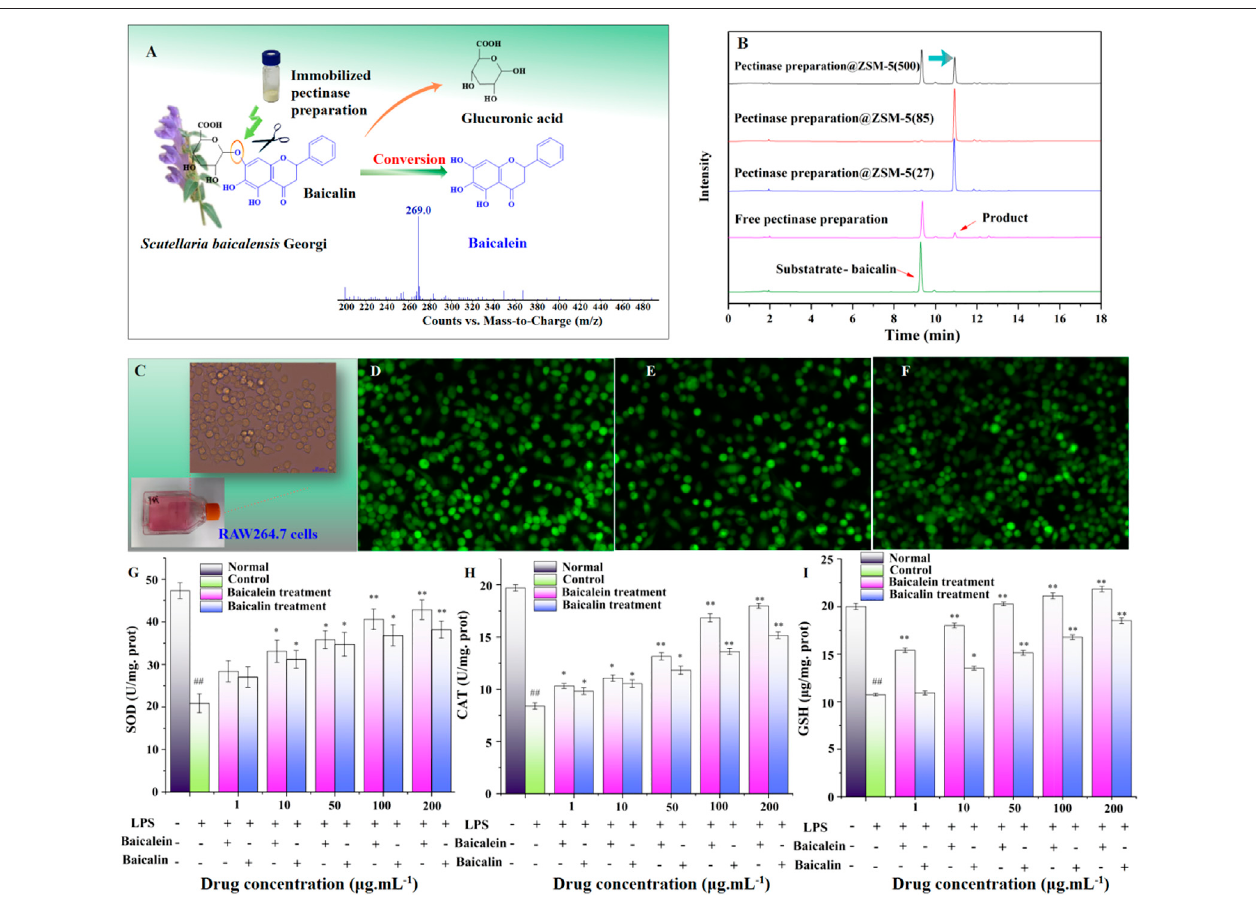
FIGURE 6 | Practical engineering application of pectinase preparation@ZSM-5: enzymatic hydrolysis of baicalin into baicalein. (A) Schematic illustration of the hydrolysis of baicalin to form baicalein using pectinase preparation@ZSM-5. (B) HPLC spectra of baicalin and as-prepared baicalein. (C) Photograph of RAW264.7 murinemacrophagecells. (D – F) Fluorescenceprobeconfocalmicroscopyimagesof (D) LPS-injuredRAW264.7cells, (E) baicalin-treatedLPS-injuredRAW264.7cells, and (F) baicalein-treatedLPS-injured RAW 264.7cells. (G – I) Effectofbaicalin and baicalein on (G) superoxide dismutase (SOD), (H) catalase (CAT), and (I) cellular glutathione (GSH) contents of LPS-injured RAW264.7 cells. Signi fi cant differences are indicated as follows: # p < 0.05 or ## p < 0.01 for the difference between the experimental condition and the 0.9% NaCl control, and p < 0.05 or ** p < 0.01 for the difference between the experimental condition and the LPS-injured RAW 264.7 control cells.